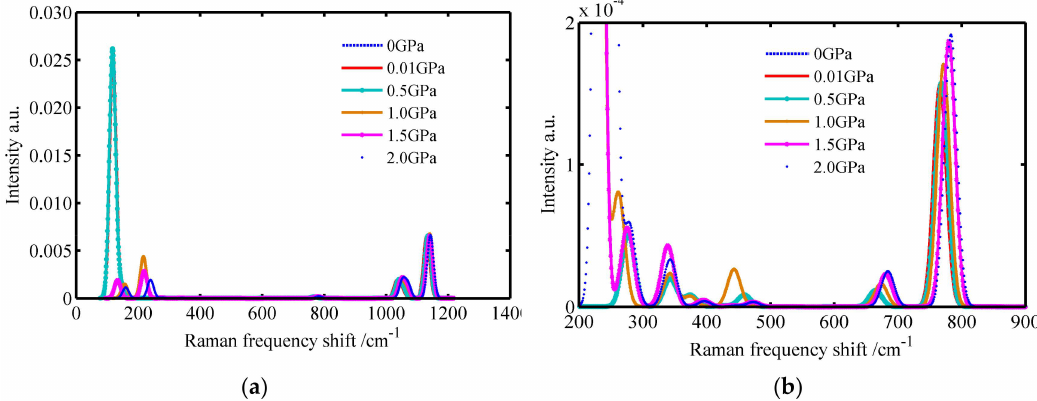
Figure 4. The Raman spectrums of α -SiO 2 crystal under di ff erent pressure. ( a ) Raman frequency shifted from 0 to 1400 cm − 1 , ( b ) Raman frequency shifted from 200 cm − 1 to 900 cm − 1